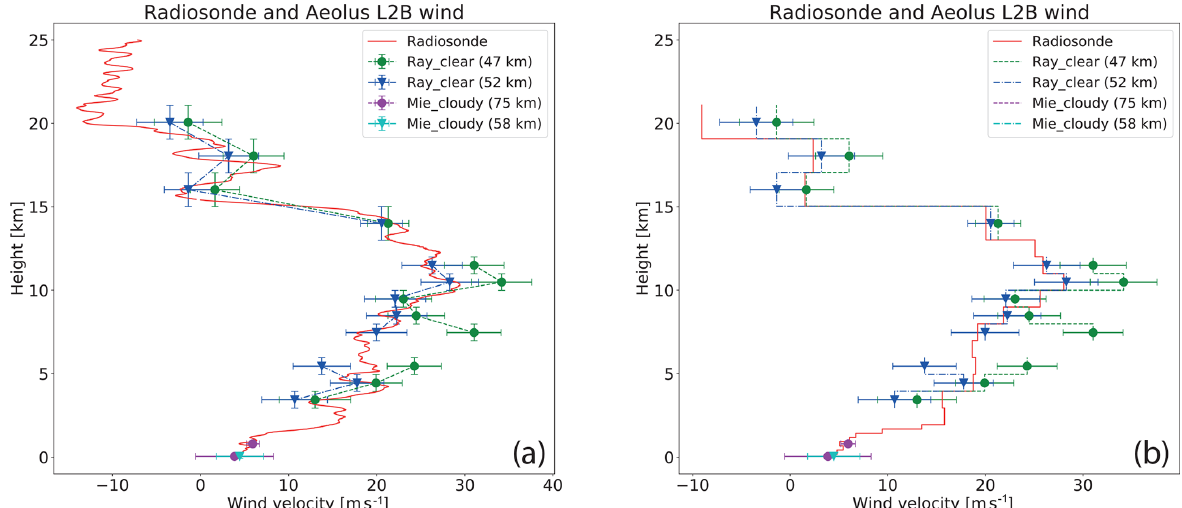
Figure 7. Wind velocity profiles measured by the radiosonde (red) with the two closest Aeolus L2B Rayleigh clear (green and blue) and Mie cloudy (magenta and cyan) profiles on 6 December 2018. The radiosonde profile is shown with its highest resolution (a) and with an adjusted resolution to the Aeolus range bin width (b) . The radiosonde measurements are projected to the HLOS of